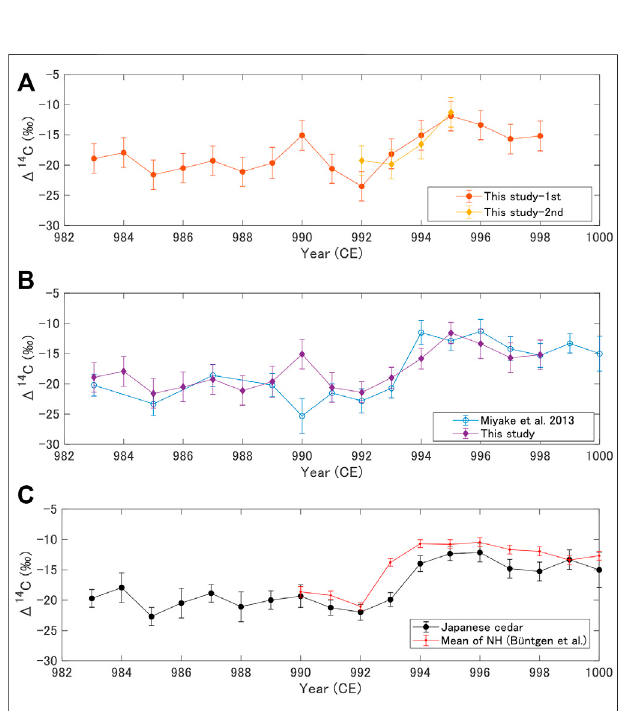
FIGURE 3 | (A) The measured 14 C data for this study. (B) Comparison with a previous result (open circles, Miyake et al., 2013) and this result (diamonds, weighted mean of Figure 3A). (C) Weighted mean of Japanese cedar datasets (black circles) and a mean of worldwide tree samples from the northern hemisphere (red dots, Büntgen et al.,